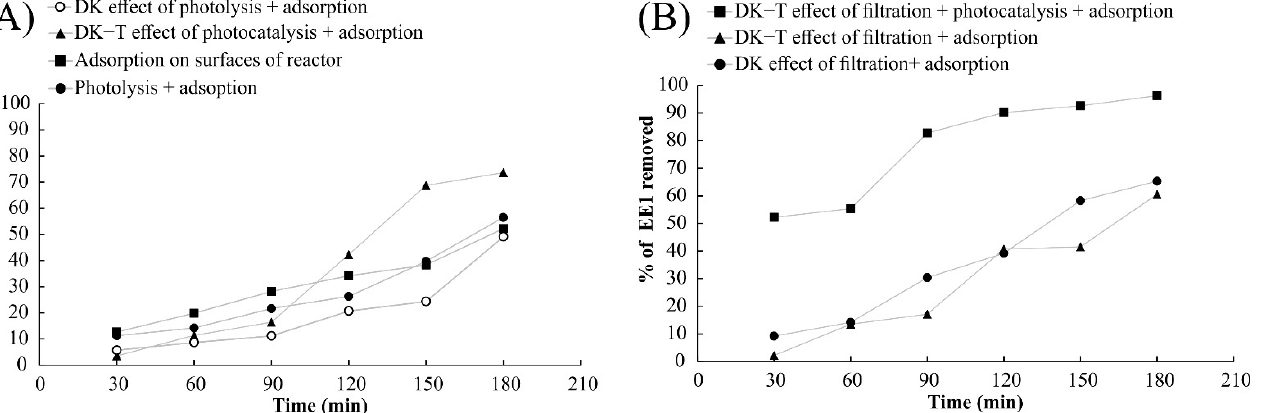
Figure 10. Evaluation of 17 α -ethinylestradiol removal from aqueous medium by adsorption, filtration, photolysis, photo- catalysis, and the combination of these processes. ( A ) Experiments without filtration and ( B ) Experiments with filtration employing DK and DK-T membranes in the hybrid